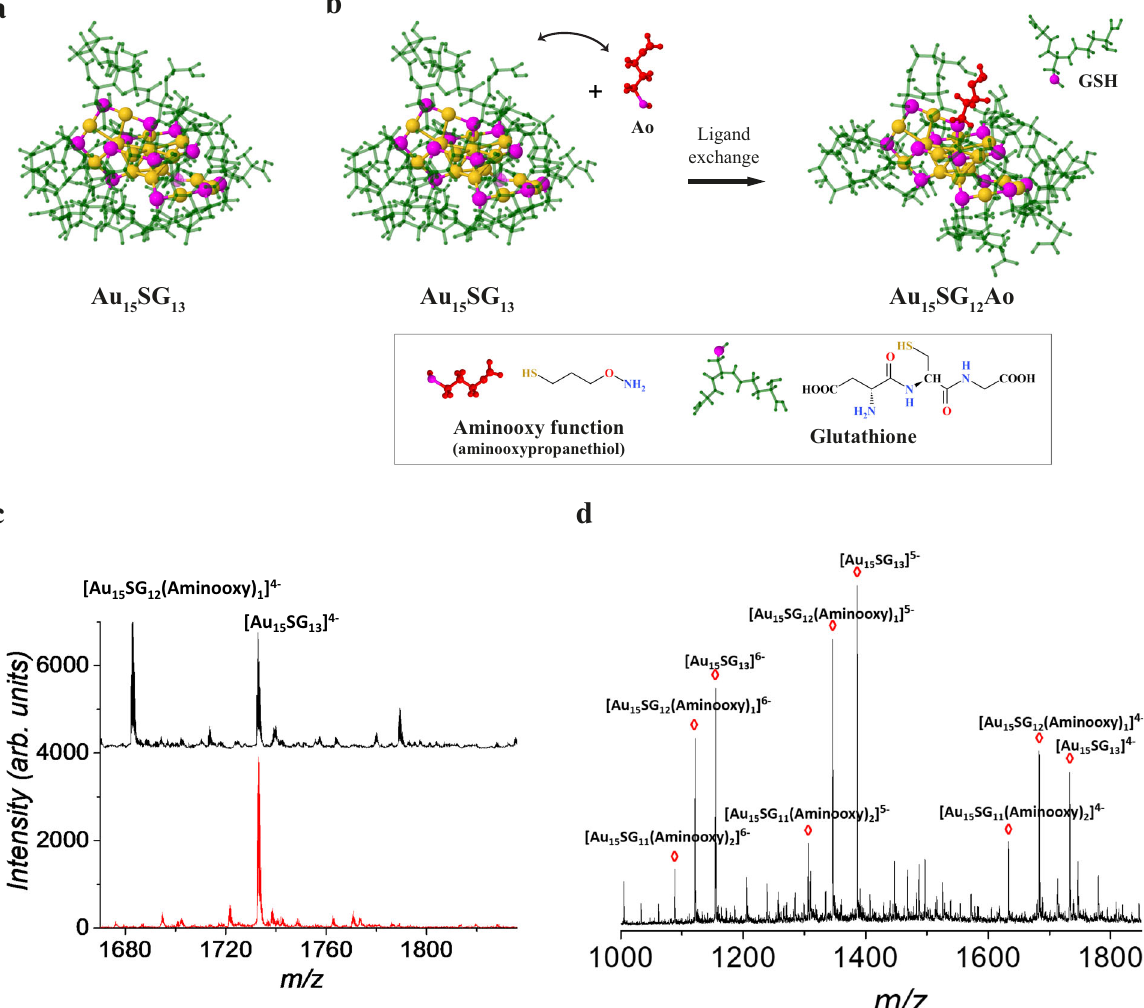
Fig. 1 Synthesis and characterization of Au 15 SG 13 and Au 15 SG 12 -Ao. a Density functional theory (DFT) structure of the gold NCs (Au 15 SG 13 ). b DFT structures illustrate the ligand-exchange strategy to functionalize the NCs with an aminooxy (Ao) function (Au 15 SG 12 -Ao). Atoms and molecules are labeled as following: S-magenta, Au-gold, glutathione-green, and aminooxypropanethiol-red c Zoom of the ESI mass spectrum of Au 15 SG 13 and Au 15 SG 12 Ao NCs corresponding to the m/z region labeled by a blue rectangle in supplementary Fig. S2a. A new peak corresponding to Au 15 SG 12 -Ao is observed following the ligand-exchange reaction. d Mass spectra showing exchange of more than one SG